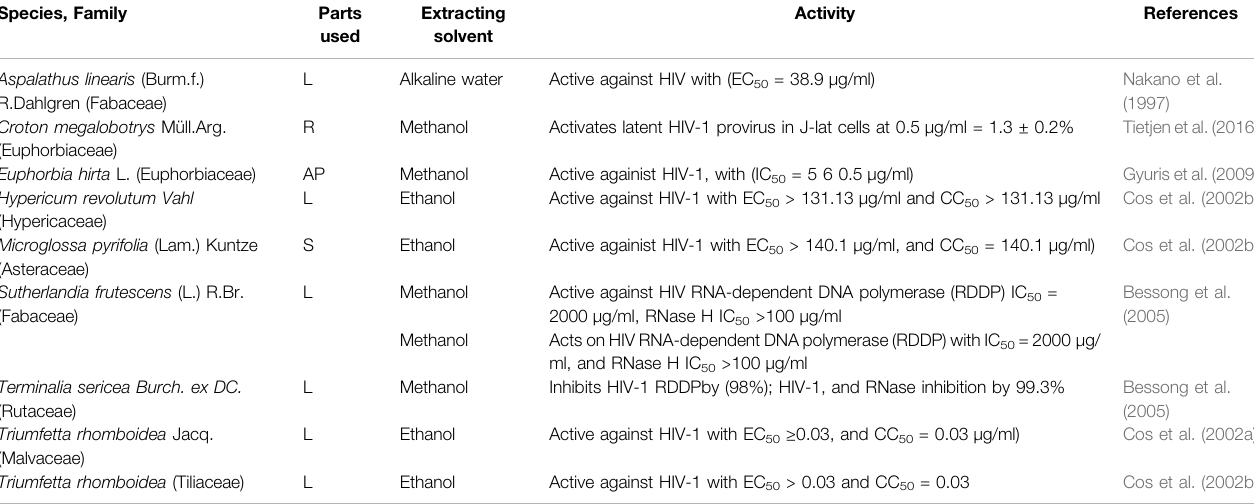
TABLE 1 | Antiviral activity of African medicinal plants against HIV virus. Species, Family